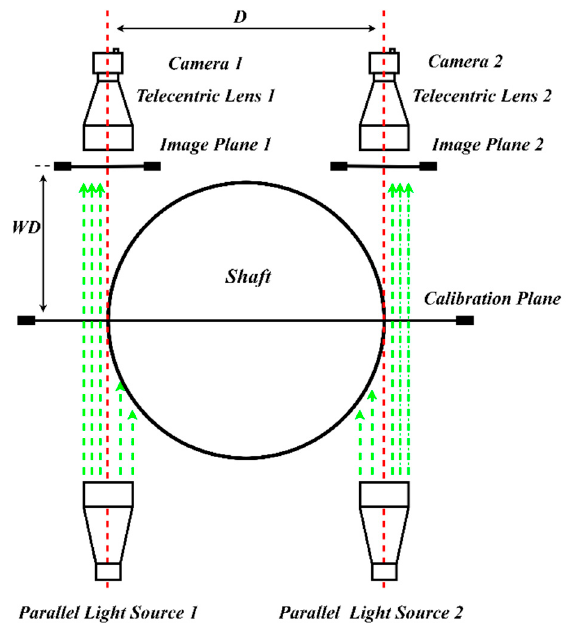
Figure 3. The layout diagram of the system.